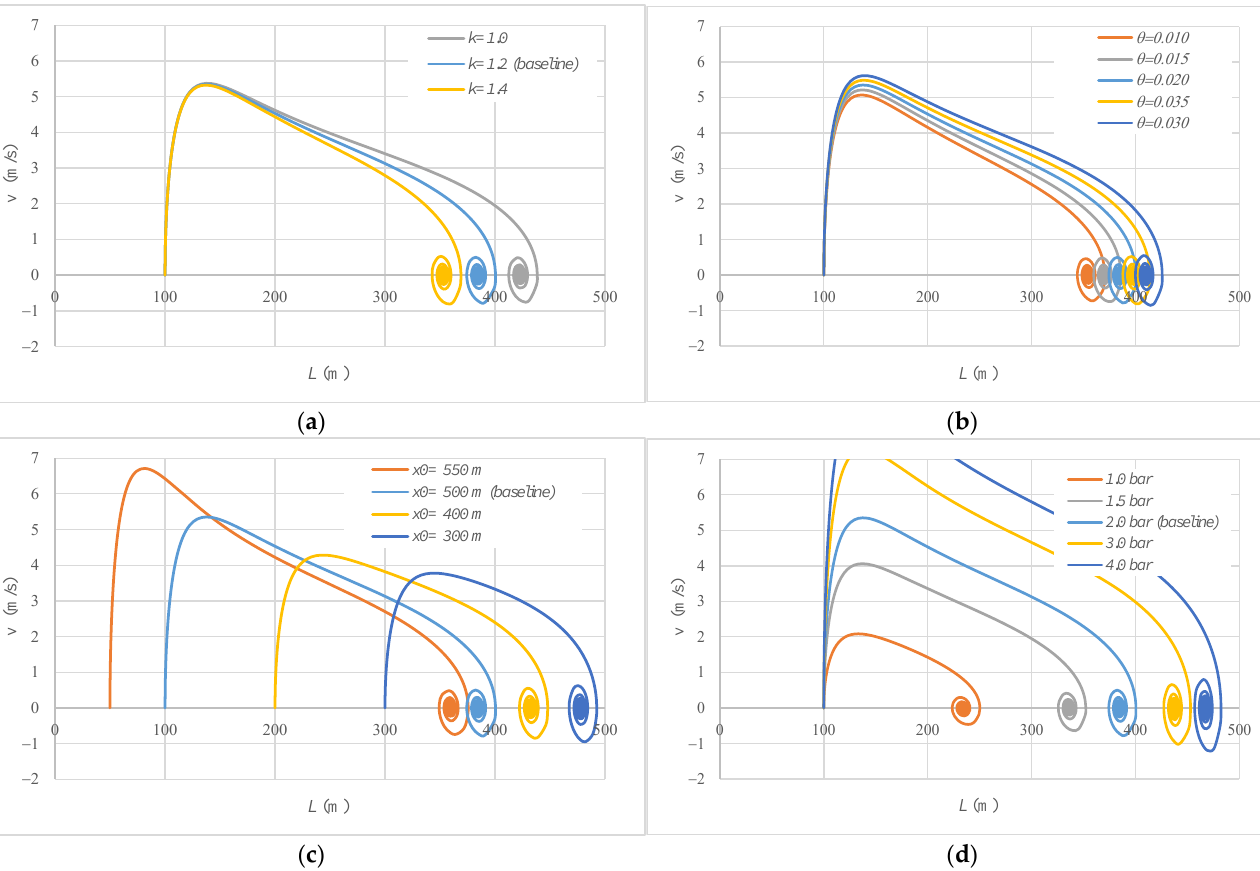
Figure 6. Sensitivity analysis for dependent parameters: ( a ) polytropic coefficient ( 𝑘 ); ( b ) pipe slope ( 𝜃 ); ( c ) air pocket size ( 𝑥 0 ); and ( d ) initial absolute pressure ( 𝑝 0∗ ).